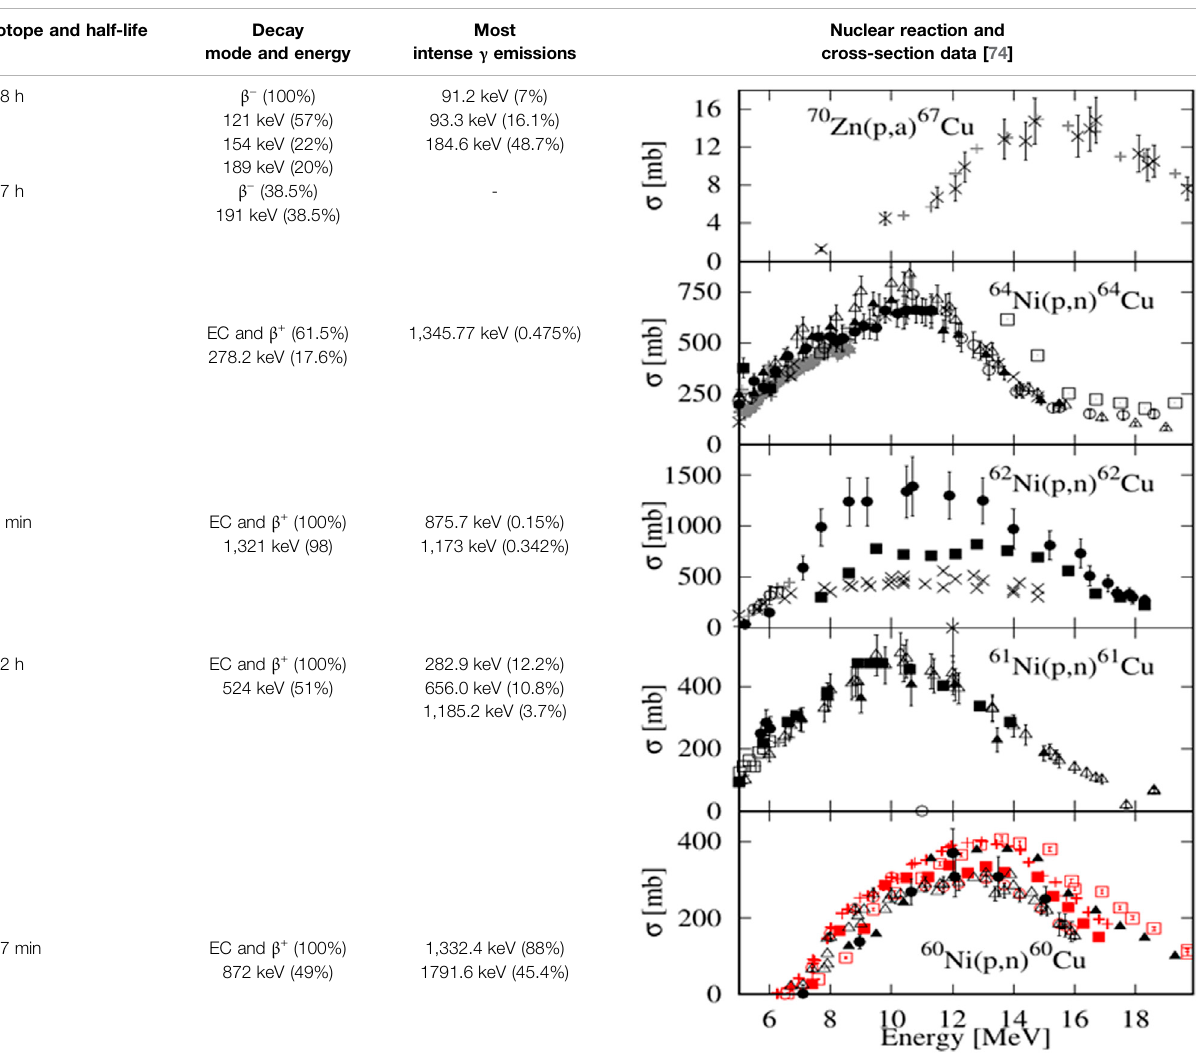
TABLE 1 | Radioisotopes of copper produced in medium energy cyclotrons. Radioisotope and half-life Decay